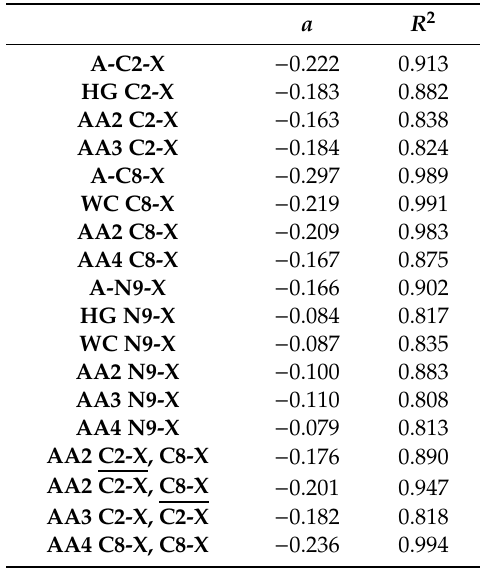
Table 1. Slopes of the obtained linear dependences c SAR(NH 2 ) vs. c SAR(X) and determination coefficients ( R 2 ) for the substituted WC and HG base pairs, adenine dimers, and substituted monomers (marked in bold , data taken from Ref. [19]) (A-C2-X, A-C8-X, A-N9-X). For asymmetrically substituted AA2 C2-X, C8-X dimer, the cSAR values of underlined monomers are taken.